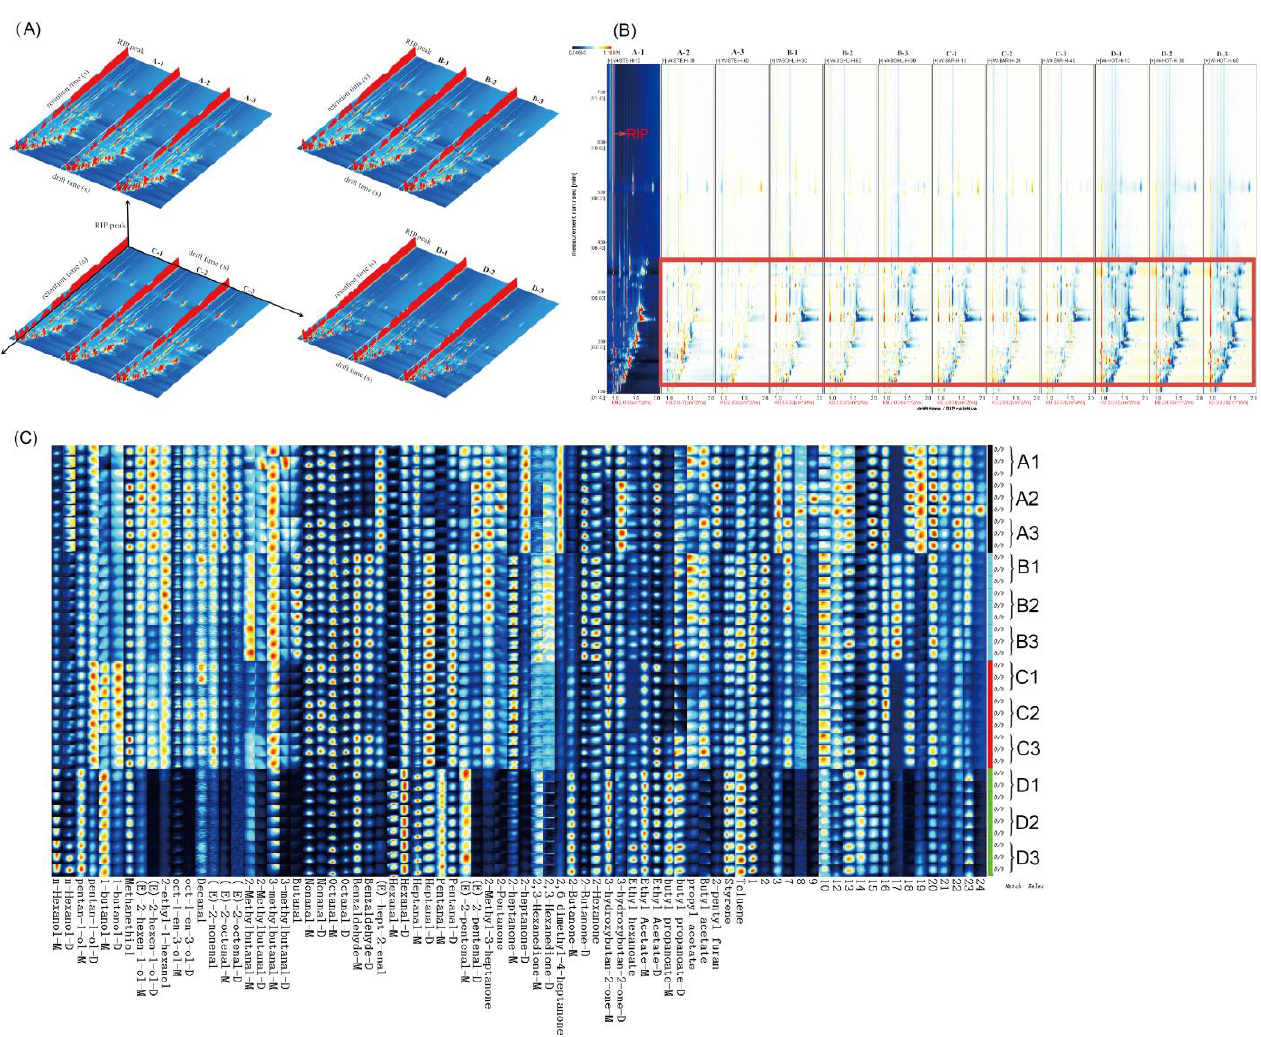
Figure 2. ( A ) Three-dimensional topographic plots of Pingliang red beef samples from different cooking samples. ( B ) Two-dimensional topographic plots of Pingliang red beef samples from different cooking samples. ( C ) GC-IMS fingerprints of Pingliang red beef samples from different cooking samples (In the figure, A stands for steaming, where A1 stands for steaming for 10 min, A2 stands for steaming for 30 min, and A3 stands for steaming for 60 min. B stands for boiling, where B1 stands for boiling for 30 min, B2 for 60 min, and B3 for 90 min. C means roasting, where C1 means roasting for 10 min, C2 means roasting for 20 min, and C3 means roasting for 40 min. D indicates instant boiling. D1 indicates instant boiling for 10 s, D2 indicates instant boiling for 30 s, and D3 indicates instant boiling for 60 s.)